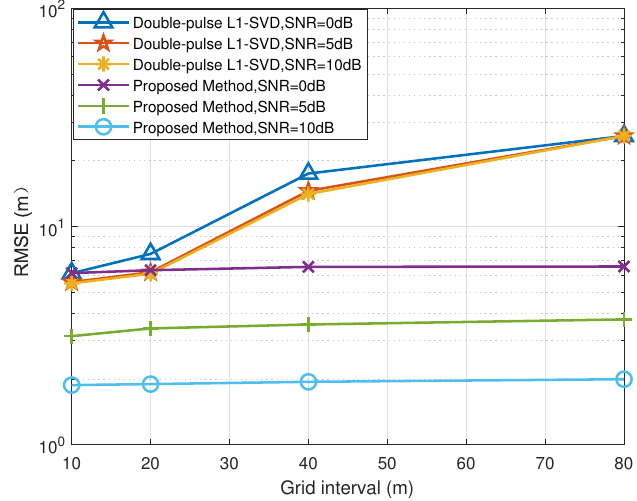
Figure 8. RMSE of range estimation versus grid